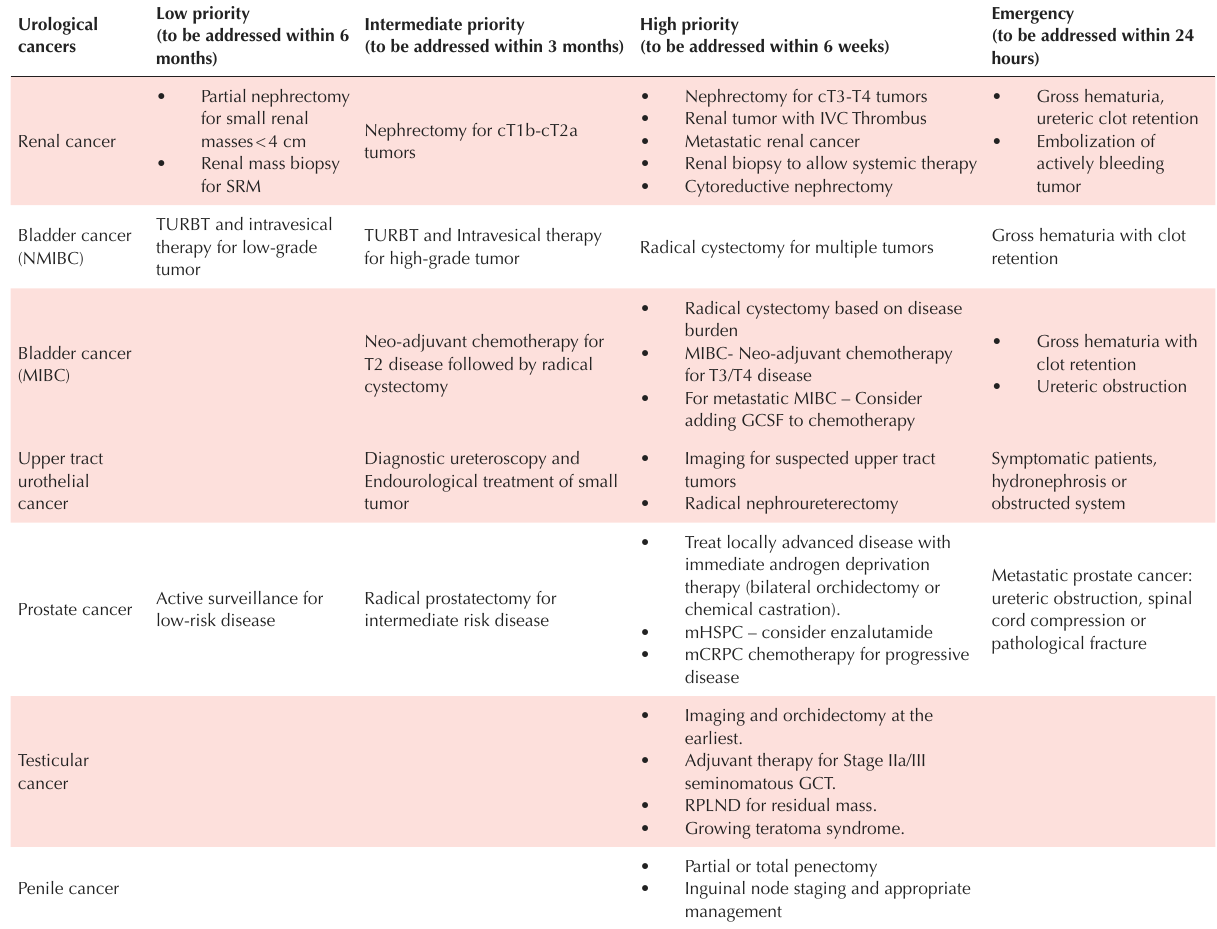
Table 1. Suggested triage of urological cancers during the COVID-19 pandemic Urological